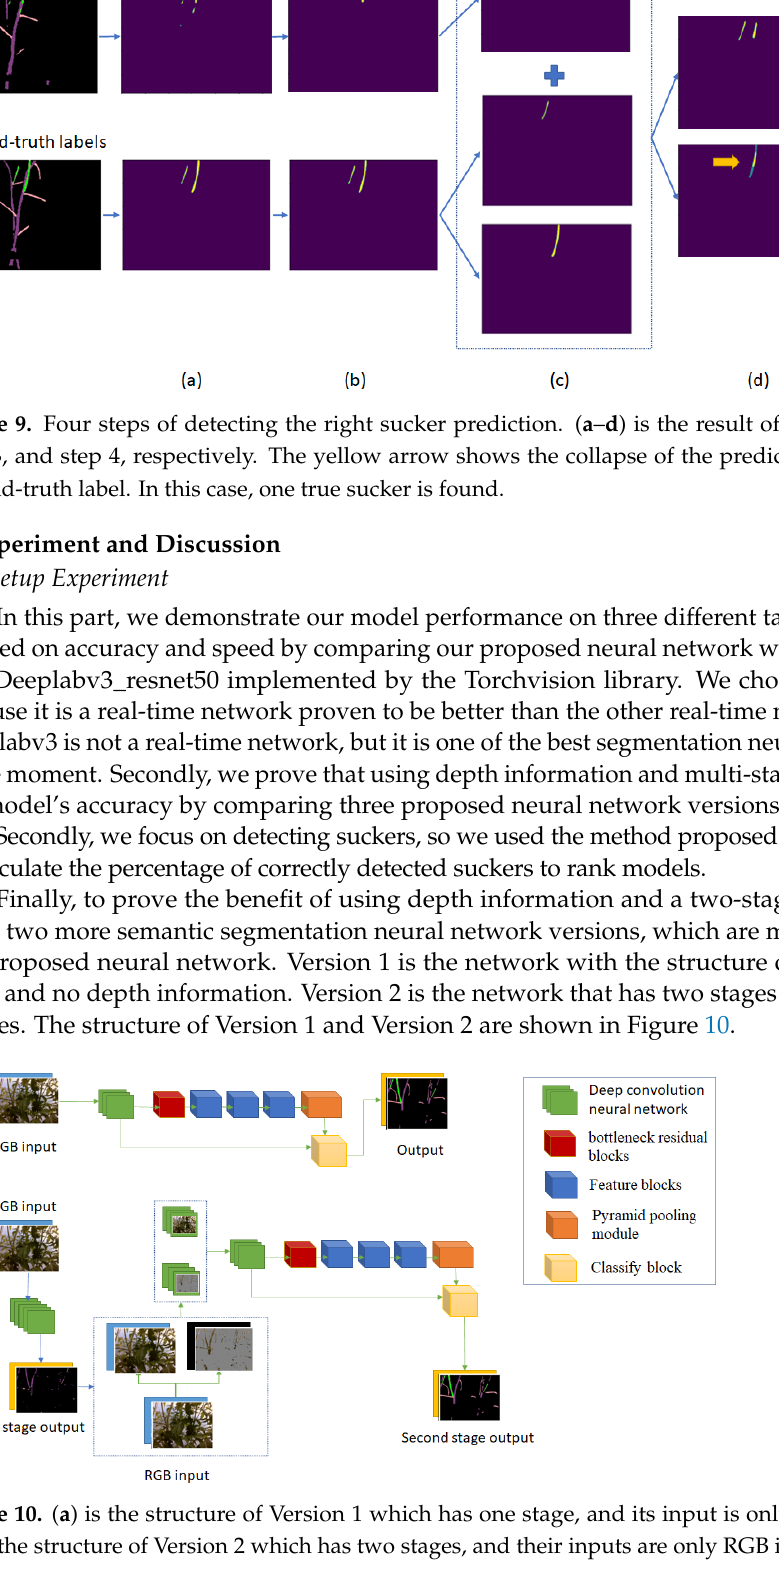
( b ) is the structure of Version 2 which has two stages, and their inputs are only RGB